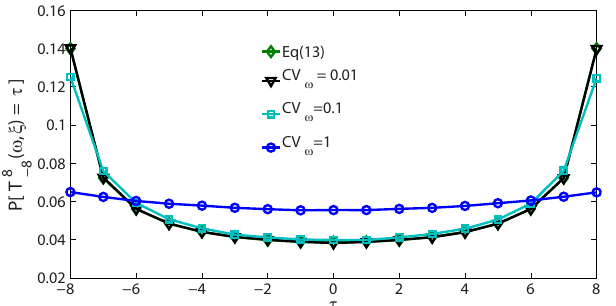
Figure 6. As the CV of ω(t) approaches zero the statistics of Eq. (3) better approximates the result in Eq. (13). Here we have shifted Eq. (13) to be centred around zero to compare with Eq. (3). Fixed parameters are: (cid:127) = 64, with N = 2 21 realizations.